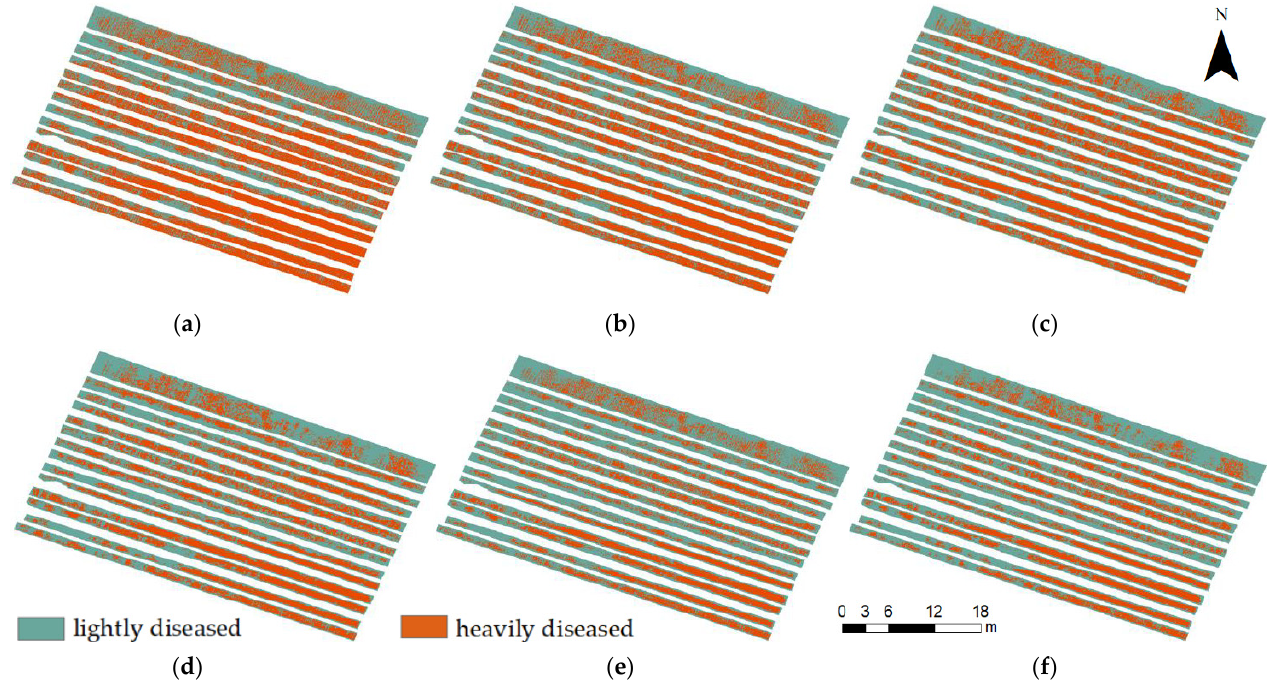
Figure 8. Detection results on May 3 ( a ) window size = 5 × 5, ( b ) window size = 9 × 9, ( c ) window size = 13 × 13, ( d ) window size = 17 × 17, ( e ) window size = 21 × 21, and ( f ) window size = 25 × 25.